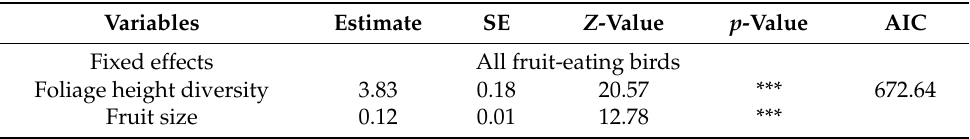
Table 2. Effects of fruit size and structural variables (FC and FHD) on fruit removal from 14 zoo- chorous tree species according to the best GLMM in a TDF successional gradient in southern Mexico. Standard error (SE), Akaike’s information criterion (AIC) and significance p -value (** p ≤ 0.01, *** p ≤ 0.001) are